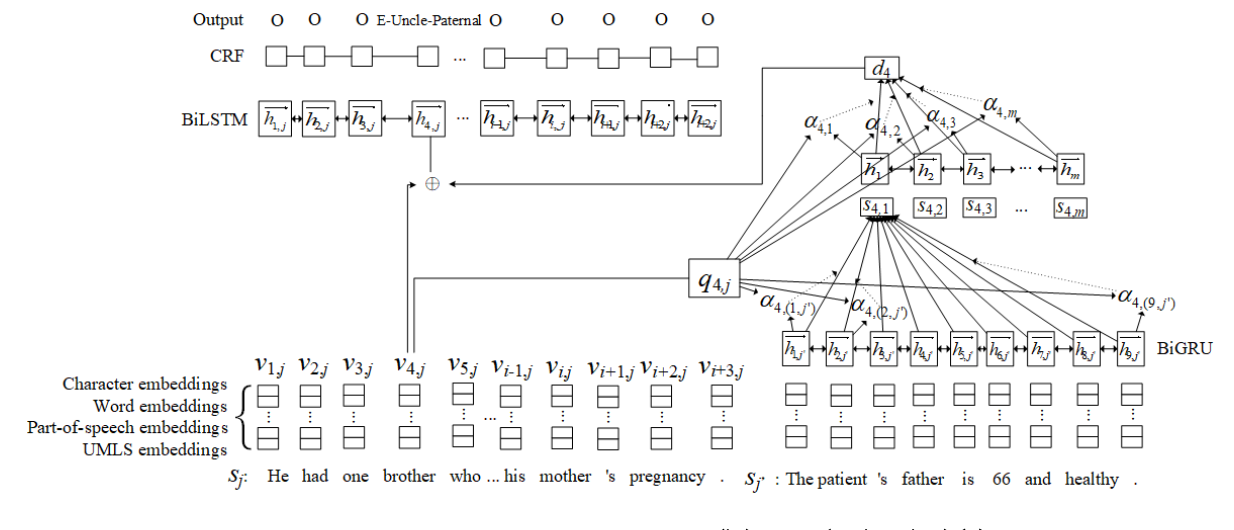
Figure 1. Proposed attention-enhanced bidirectional long short-term memory (BiLSTM)-conditional random field (CRF) network architecture. ⊕ indicates a concatenation of two vectors. BiGRU: bidirectional gated recurrent unit; UMLS: Unified Medical Language